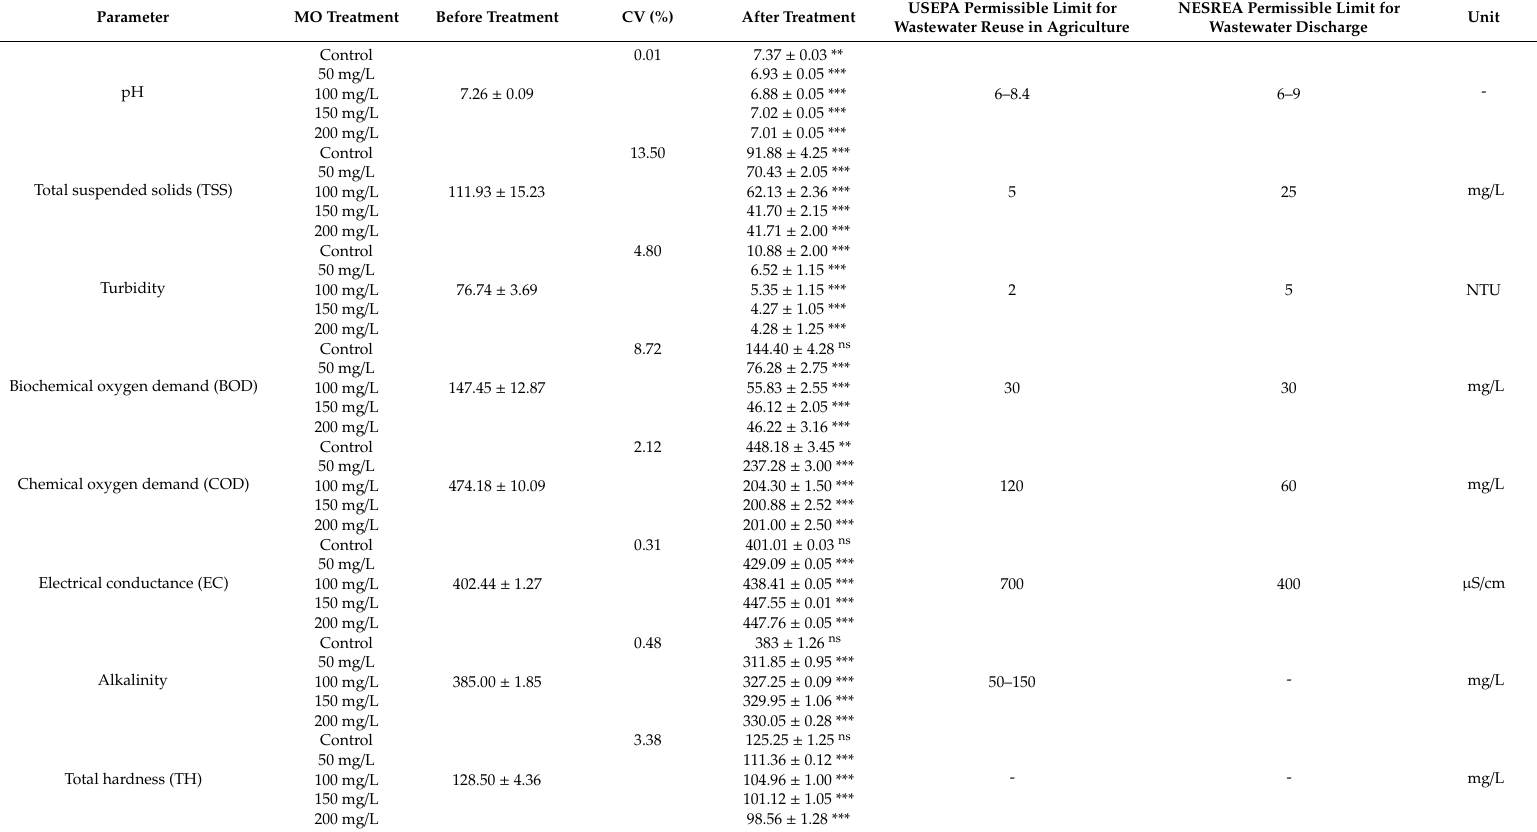
Table 1. Characteristics of municipal wastewater used for this